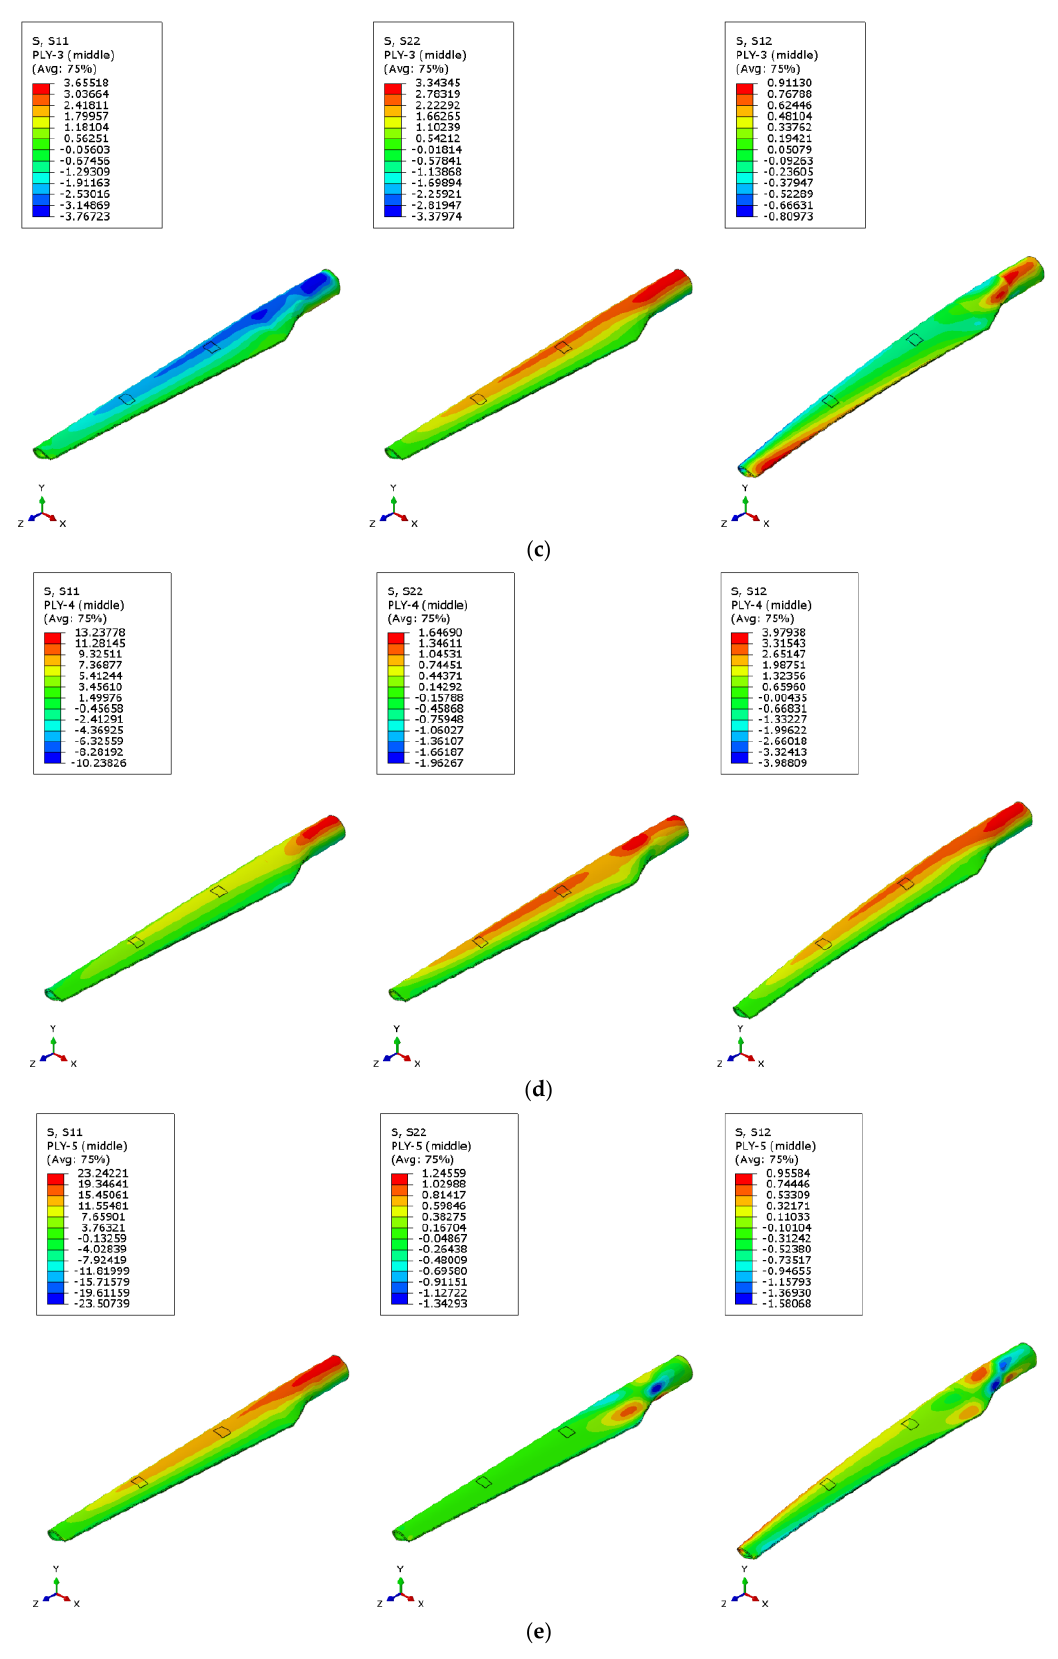
Figure 5. The distribution of normal and shear stresses in the WTB, without damage (case 1): ( a )